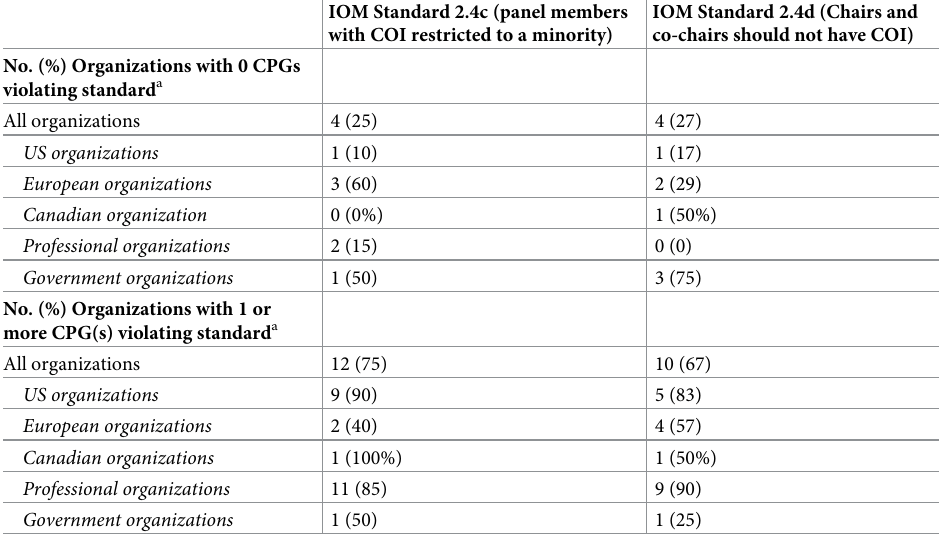
a Percentages are calculated from the number of organizations with policies meeting the respective standard, as found for each subgroup in Table